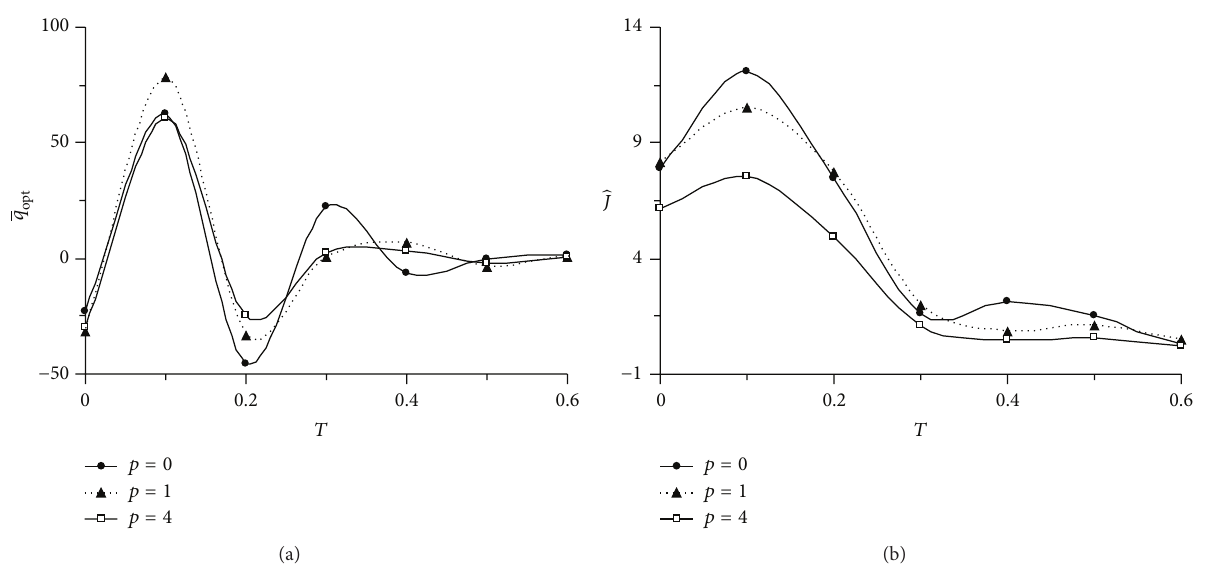
̂𝐽 , (b) for the energy , against the time 𝑇 , ℎ = 0.02 m and 𝑎/𝑏 = 1 . opt